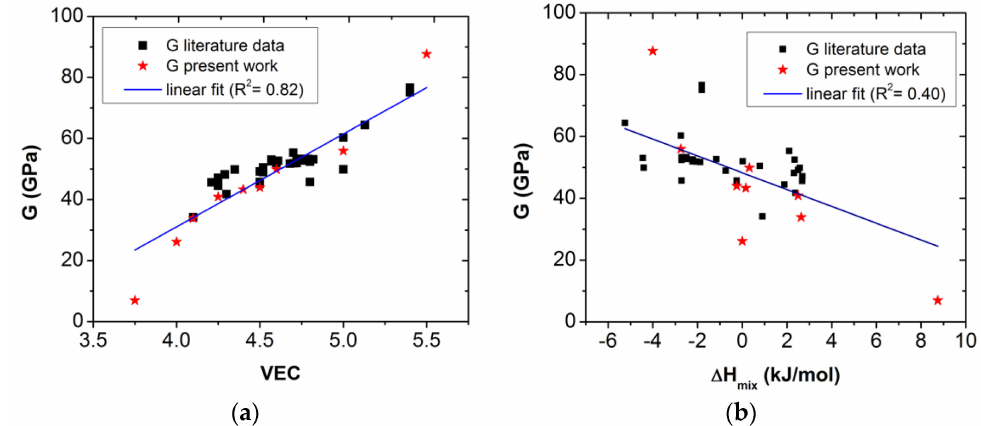
Figure 2. G , in the function of VEC ( a ); and of ∆ H mix ( b ) for the various ETM-based RHEA samples listed in Table 1.